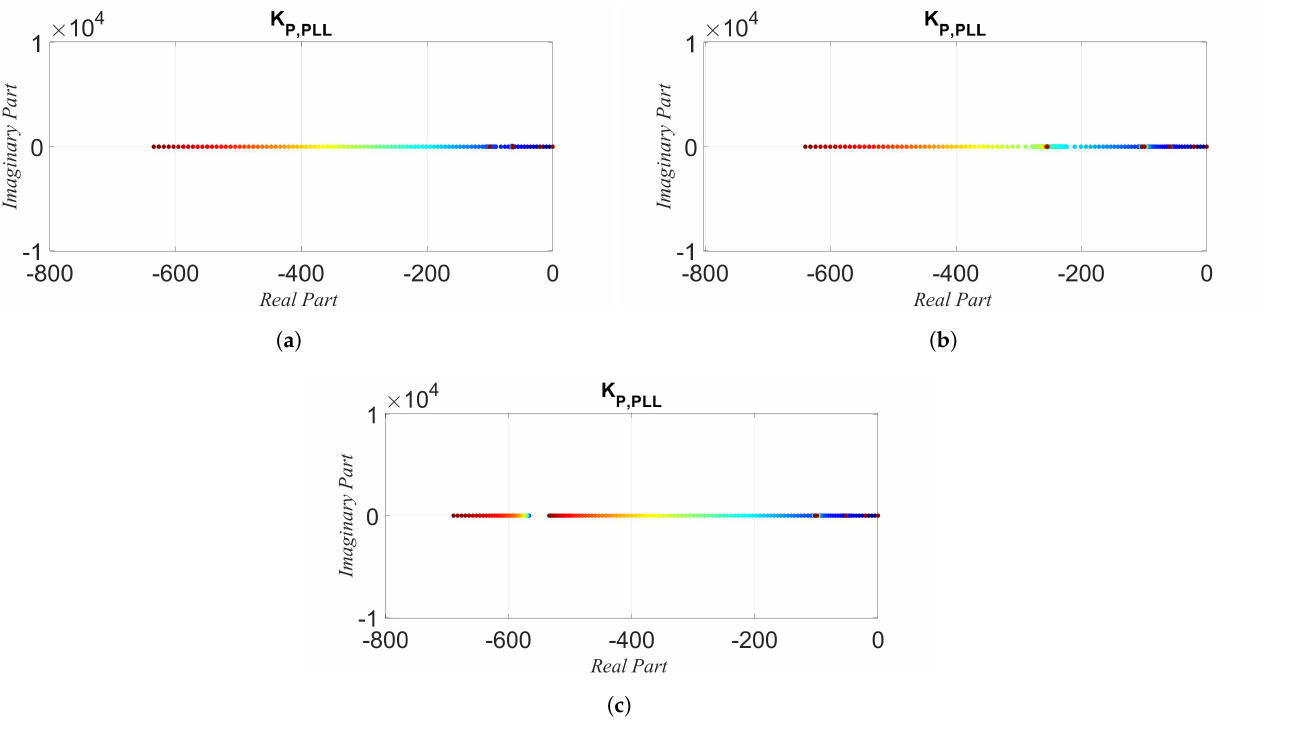
Figure 9. Eigenvalue − based stability analysis for different AVC filter cases in the strong grid case scenario (SCR = 10). K P , PLL 0 varies from 0.1 (deep blue) to 10 (deep red) times. ( a ) f AVC,LPF = 20